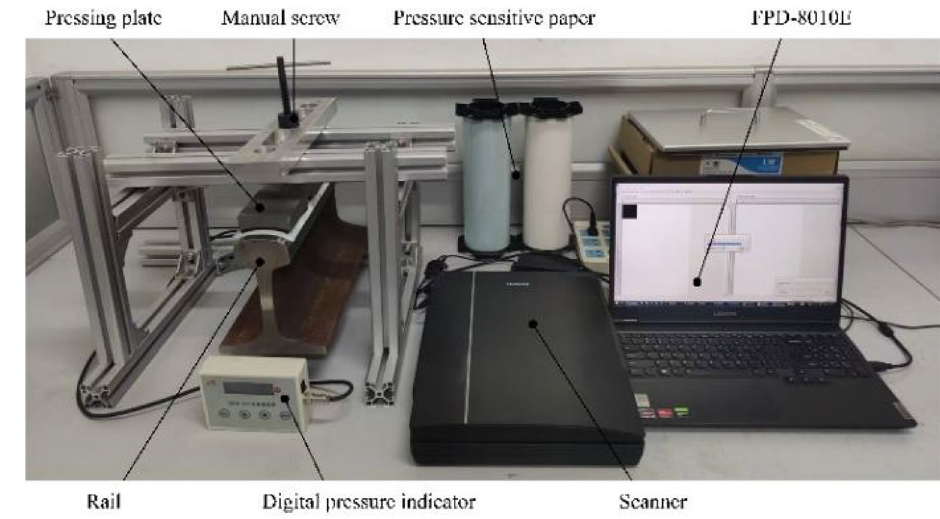
Figure 10 Experimental device for grinding contact between rail, pressing plate and abrasive belt